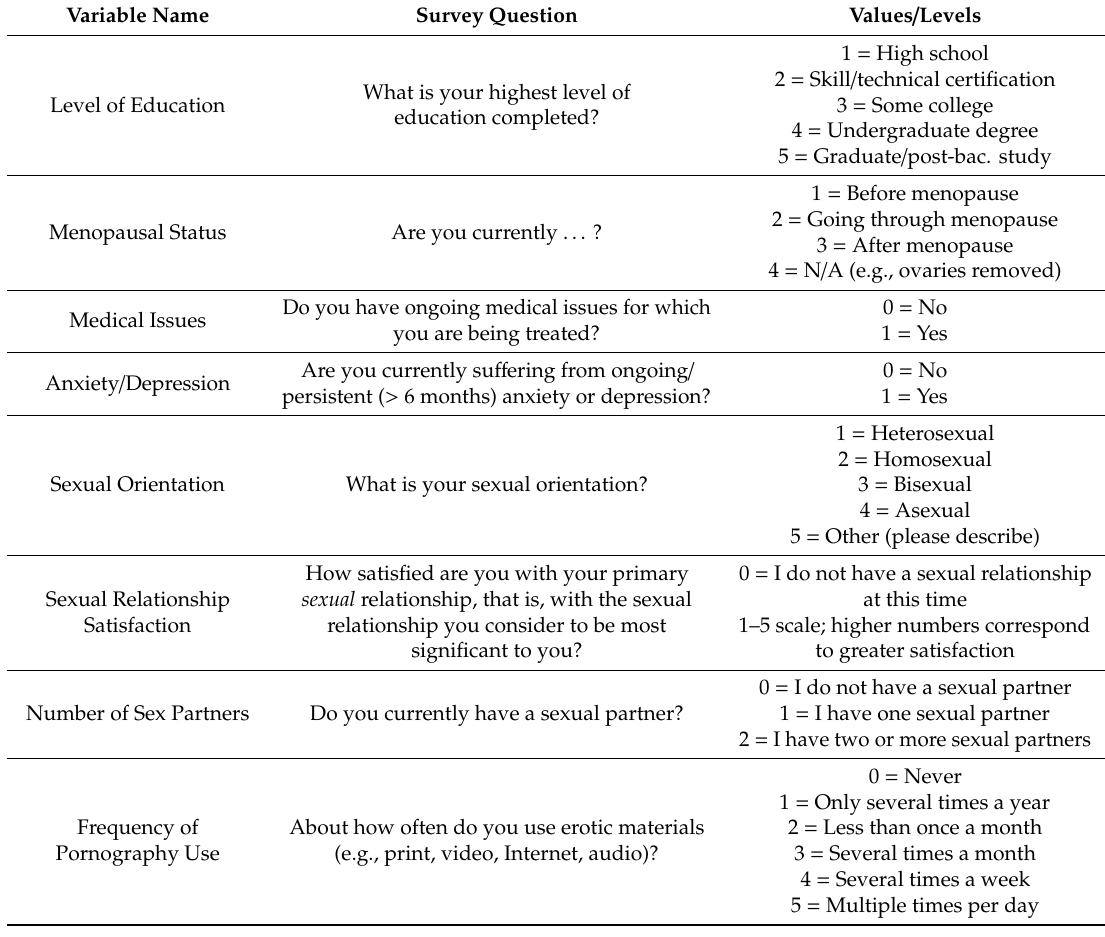
Table A1. Survey questions for the regression covariates.